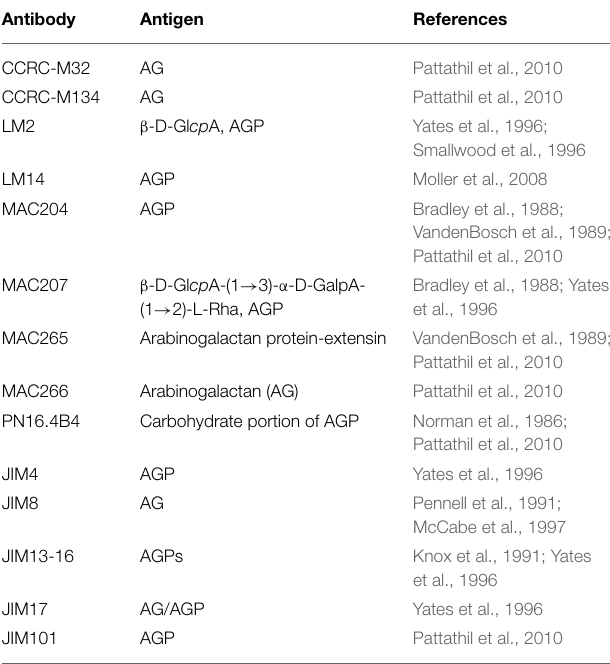
TABLE 1 | Antibodies used and their corresponding